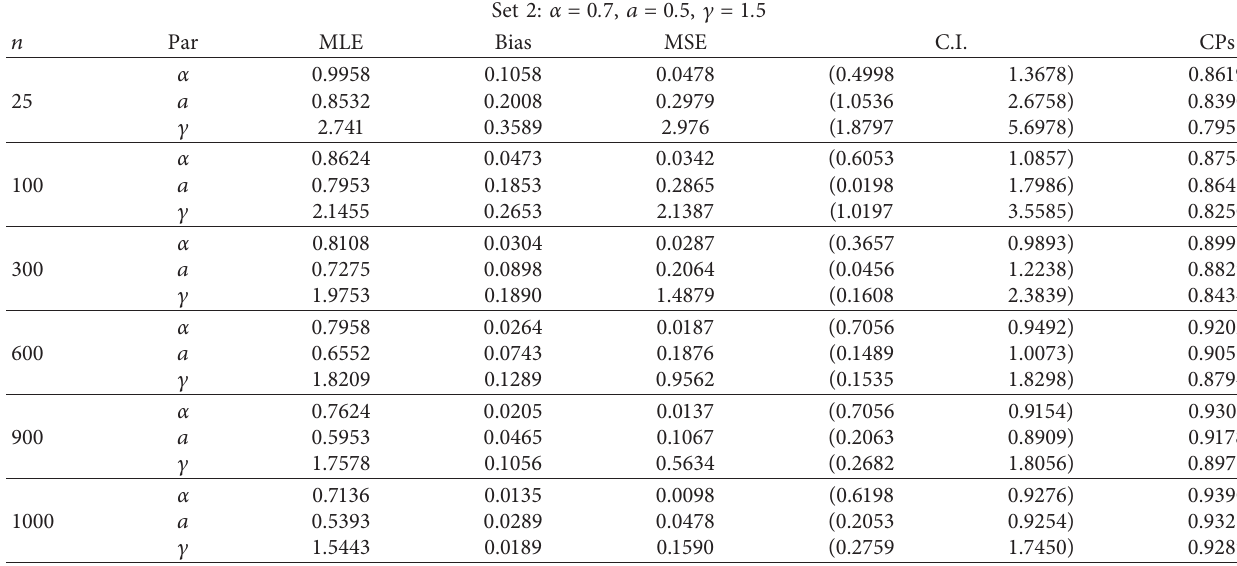
Table 3: MLE, Bias, MSE, C.I., and CPs of the ASE-W parameters.